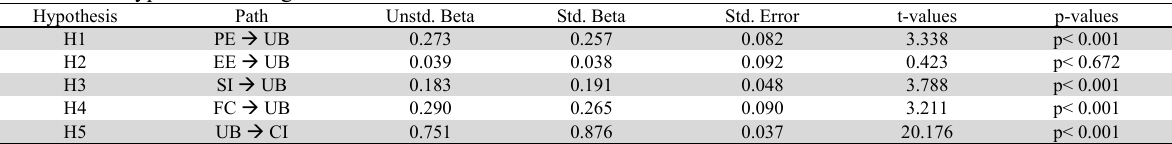
The result of hypothesis